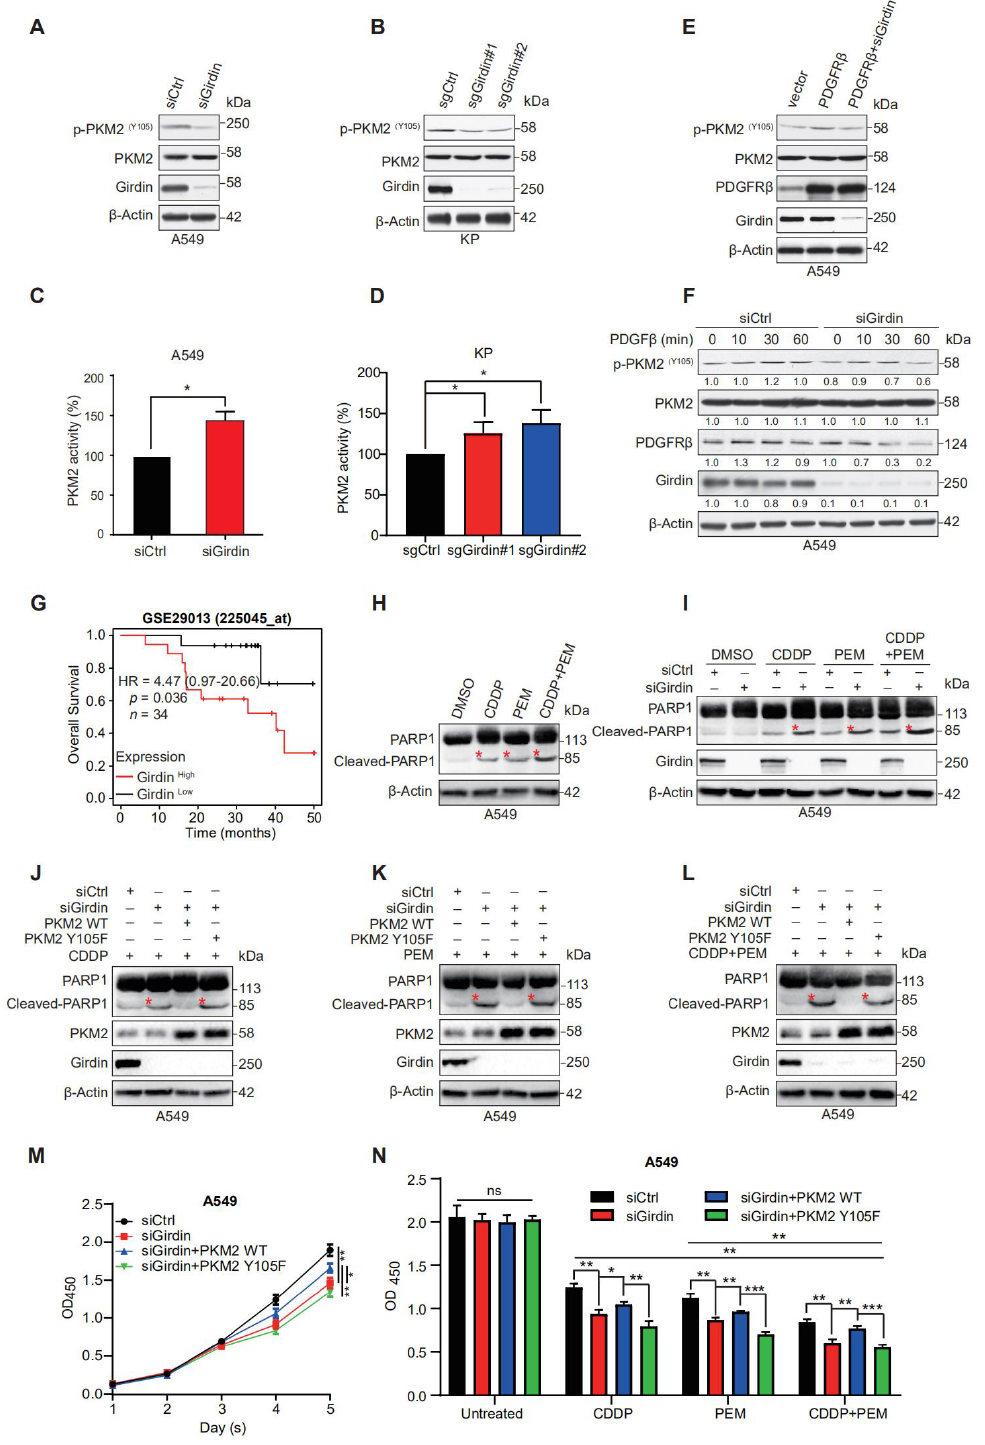
Figure 5. Girdin develops chemoresistance via PKM2. ( A , B ) The phosphorylation levels of PKM2